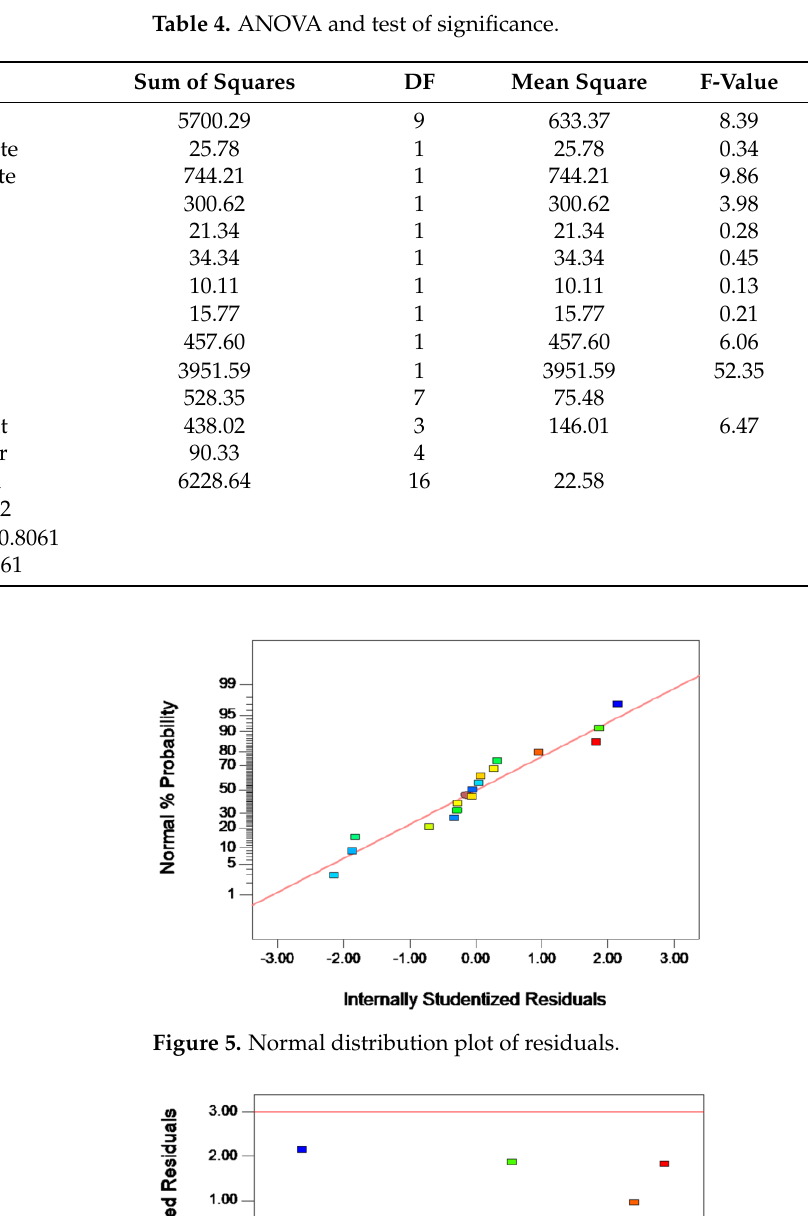
Table 4. ANOVA and test of significance.